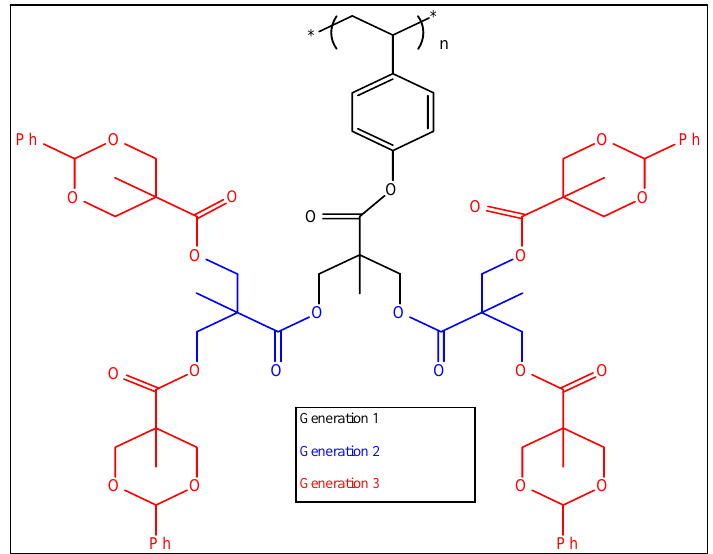
Figure 3. Dendronized polymer with different